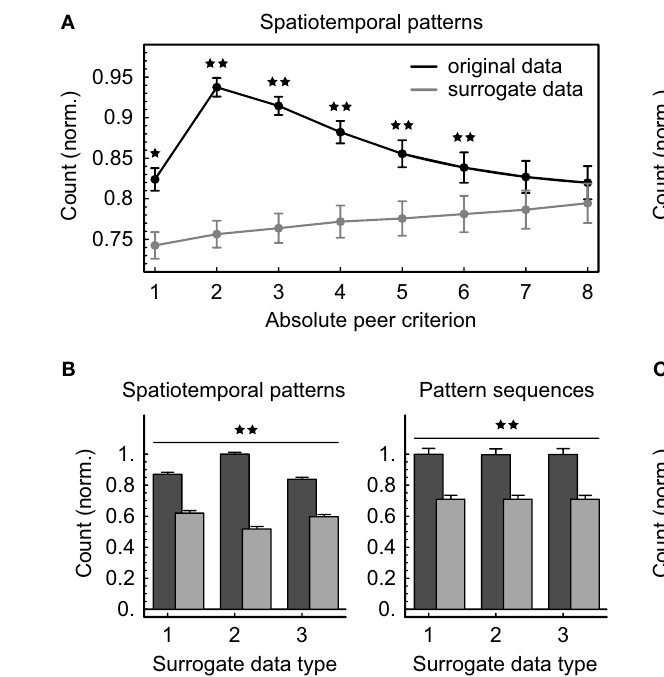
absolute peer criterion A applied in addition to the threshold given by Eq. (1) (number of surrogates: 20, surrogate data generated by combined spike train shifting and interval shuffling). (B) Counts depending on the surrogate data type (1: shifting spike trains, 2: dithering individual spike times with the “square root dither” method, 3: shifting spike trains and shuffling intervals, number of surrogates: 100, absolute peer criterion: 2). Original counts are displayed in dark gray, surrogate counts in light gray. (C) Counts depending on the number of surrogates (absolute peer criterion: 2, surrogate data generated by combined spike train shifting and interval